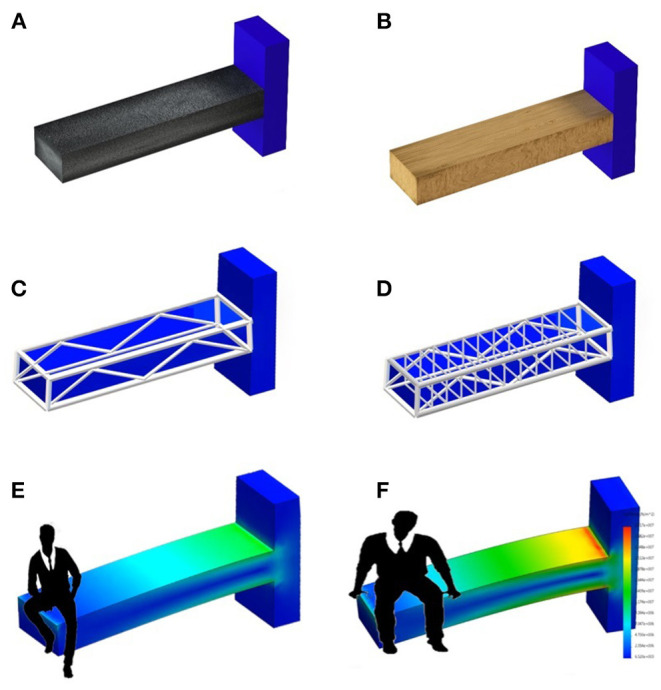
Example of the information level provided by BMD, TBS and BSI related to a man sitting on a beam. (A,B) Show the difference in materials (e.g., concrete and wood) that can be assessed by BMD DXA measurement. (C,D) Relate to internal structure design showing a difference between a dense and a sparse structure, and using the same concept of TBS. (E,F) Show the stress-strain status of a bar made up of a specific material and with a specific structure, with two different people sitting on the top. The information provided by (E,F) is the same provided by BSI.